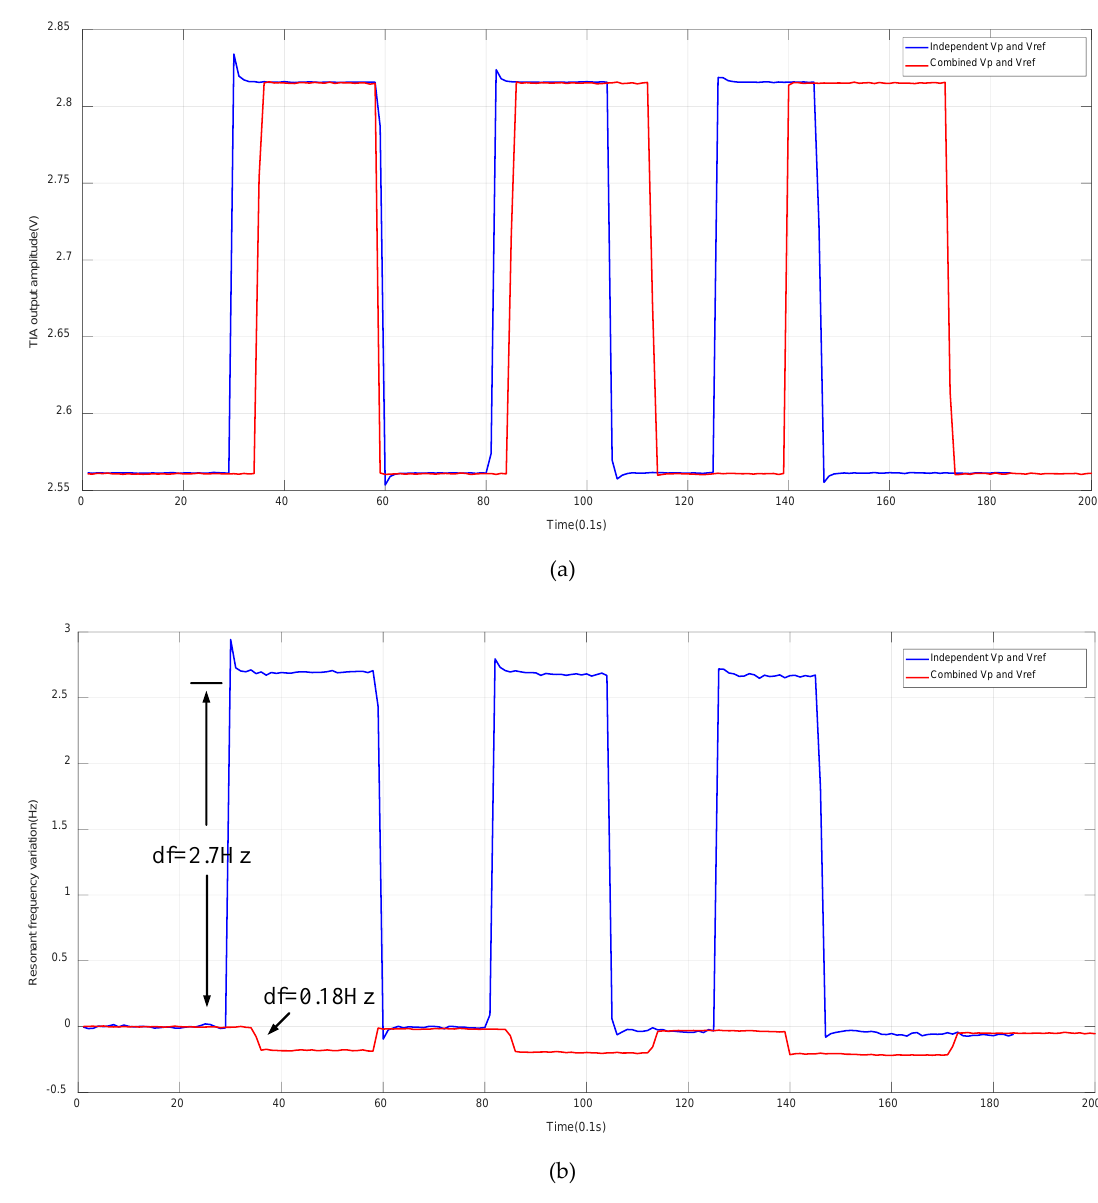
Figure9. Variationcomparisonof( a )TIAoutputamplitudeand( b )itsfrequencywithself-compensation Figure 9. Variation comparison of (a) TIA output amplitude and (b) its frequency with self- strategy or compensation strategy or not.